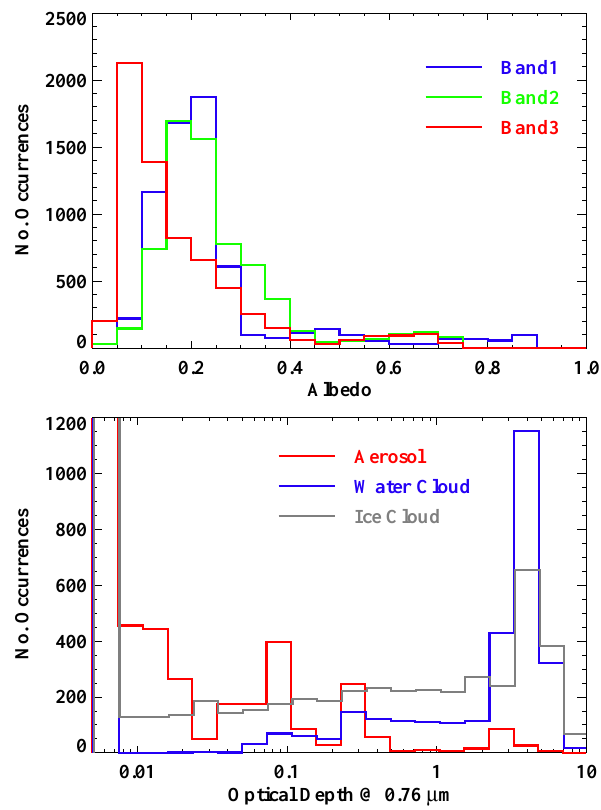
Fig. 5. (a) Distributions of simulated reflectance at the center of each spectral band, calculated for the primary scattering angle (so- lar angle to observation angle). The spectral bands are defined in Table 1. (b) Distributions of simulated aerosol, cloud water, and cloud ice optical depth at